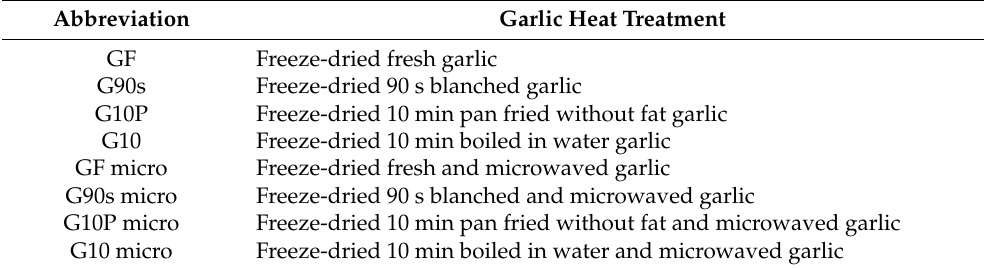
Table 1. Garlic heat treatment